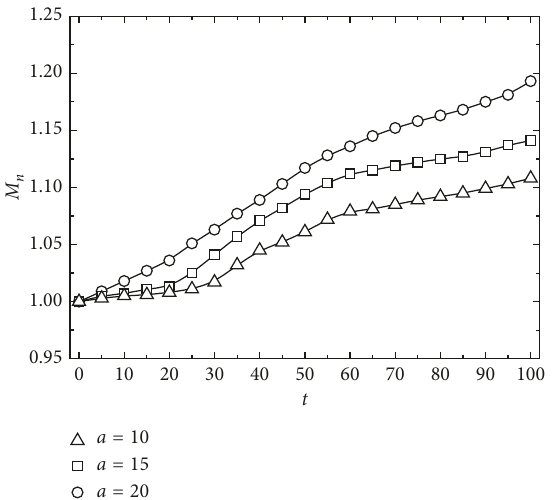
Figure 6: Change of inhomogeneous degree with time at different a (Re � 200 and St �